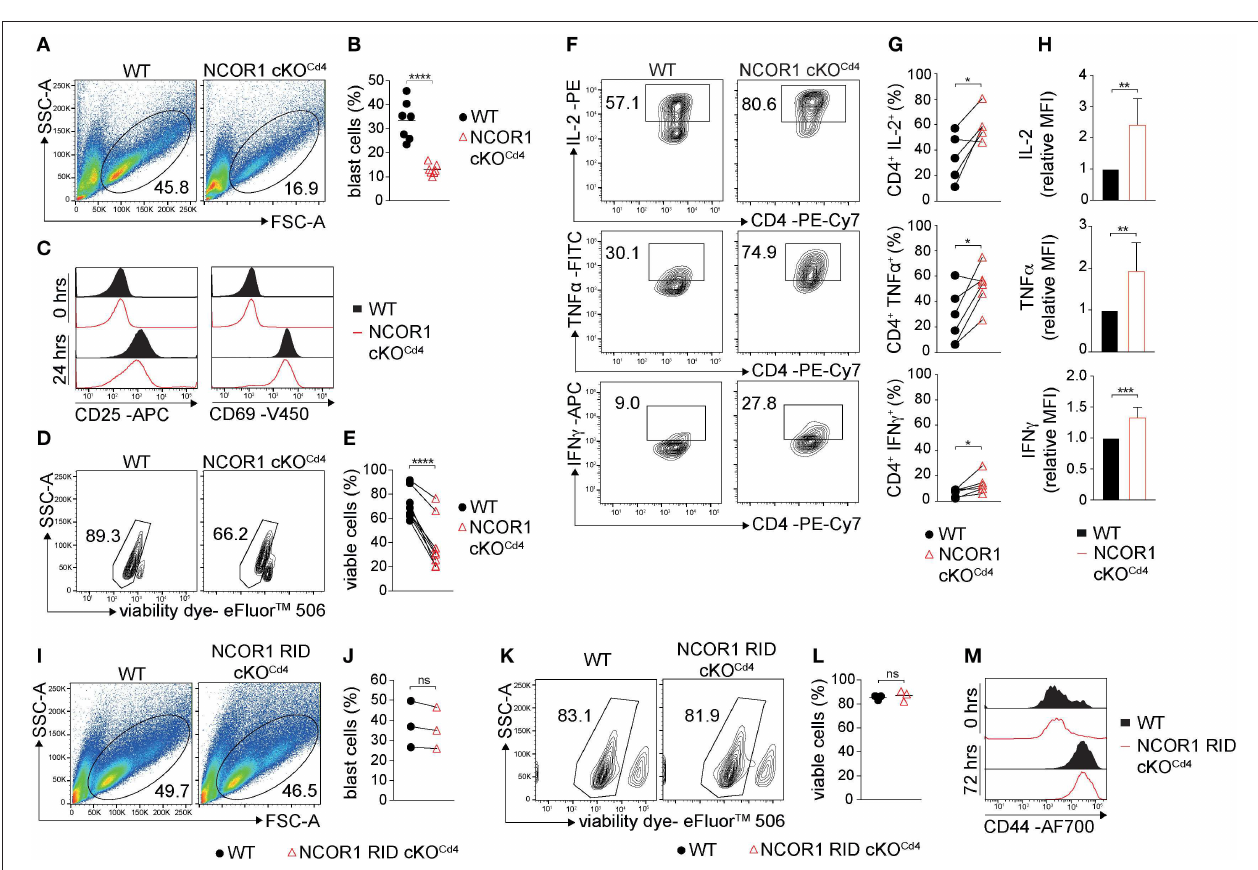
FIGURE 2 | NCOR1 controls the survival of in vitro -activated CD4 + T cells. (A) Naïve WT and NCOR1 cKO Cd4 CD4 + T cells were activated with anti-CD3 ε /anti-CD28 and cultured in the presence of recombinant hIL-2 for 3 days ( = Th0 condition). Pseudocolor plots show side scatter (SSC-A) vs. forward scatter (FSC-A). Regions indicate T cell blasts. (B) Summary diagram shows the percentage of T cell blasts from all experiments performed as described in (A) . (C) Representative histograms depict expression of CD25 (left) and CD69 (right) on WT and NCOR1 cKO Cd4 Th0 cells before (0h; upper histograms) and 24h (lower histograms) after activation. (D) Representative contour plots of viability dye vs. side scatter (SSC-A) for WT and NCOR1 cKO Cd4 Th0 cells. (E) Summary of all experiments performed as described in (D) shows percentages of viable WT and NCOR1 cKO Cd4 Th0 cells. (F) Contour plots depict IL-2, TNF α , and IFN γ vs. CD4 expression in WT and NCOR1 cKO Cd4 Th0 cells. (G) Summary showing results of all experiments as described in (F) . (H) Summary graphs depicting cytokine expression levels as mean fluorescence intensity (MFI). For each experiment, WT levels were set as 1 and relative MFI of IL-2, TNF α , and IFN γ are shown. (I) MACS-purified naïve WT and NCOR1 RID cKO Cd4 CD4 + T cells were activated as described in (A) . Pseudocolor plots show side scatter (SSC-A) vs. forward scatter (FSC-A) for WT and NCOR1 RID cKO Cd4 Th0 cells. (J) Summary diagrams of all experiments performed as described in (I) showing the percentages of WT and NCOR1 RID cKO Cd4 Th0 blast cells. (K) Contour plots of viable WT and NCOR1 RID cKO Cd4 Th0 cells. (L) Percentages of viable WT and NCOR1 RID cKO Cd4 Th0 cells from all experiments as described in (K) . (M) Representative histograms depict expression of CD44 on WT and NCOR1 RID cKO Cd4 Th0 cells before (0h, upper histograms) and 72h (lower histograms) after activation. (B,L) The horizontal bars indicate the mean. * P < 0.05, ** P < 0.01, *** P < 0.001, **** P < 0.0001, ns, not significant (unpaired two-tailed t -test or paired t -test for E,G,J ). (A,D,F,I,K) Numbers indicate the percentage of cells in the respective regions. (E,G,J) Lines indicate paired experiments. Data are representative (A,C,D,F,I,K,M) or show summary (B,E,G,H,J,L) of 7 (B) , 3 (J,L) , 8 (E) , and 5–6 (G,H) samples that were analyzed in 3–8 independent experiments.